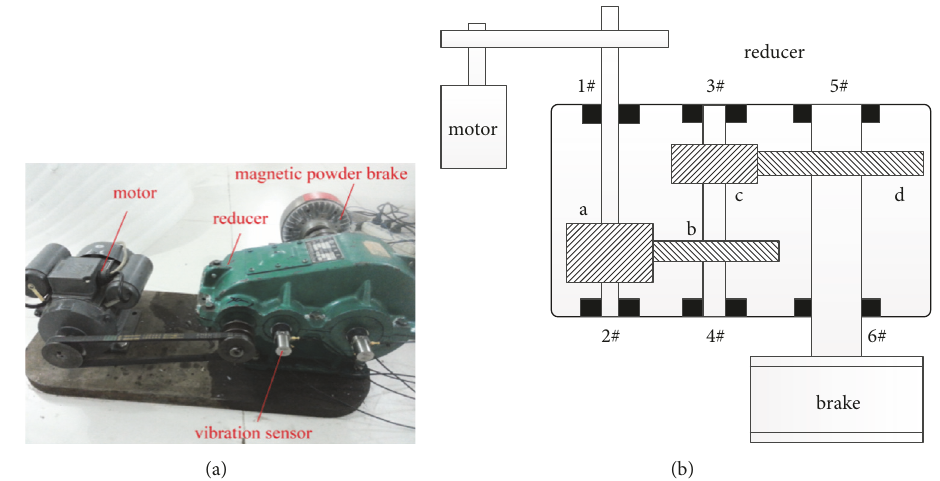
Figure 6: Experimental device: (a) part name, (b) part number.